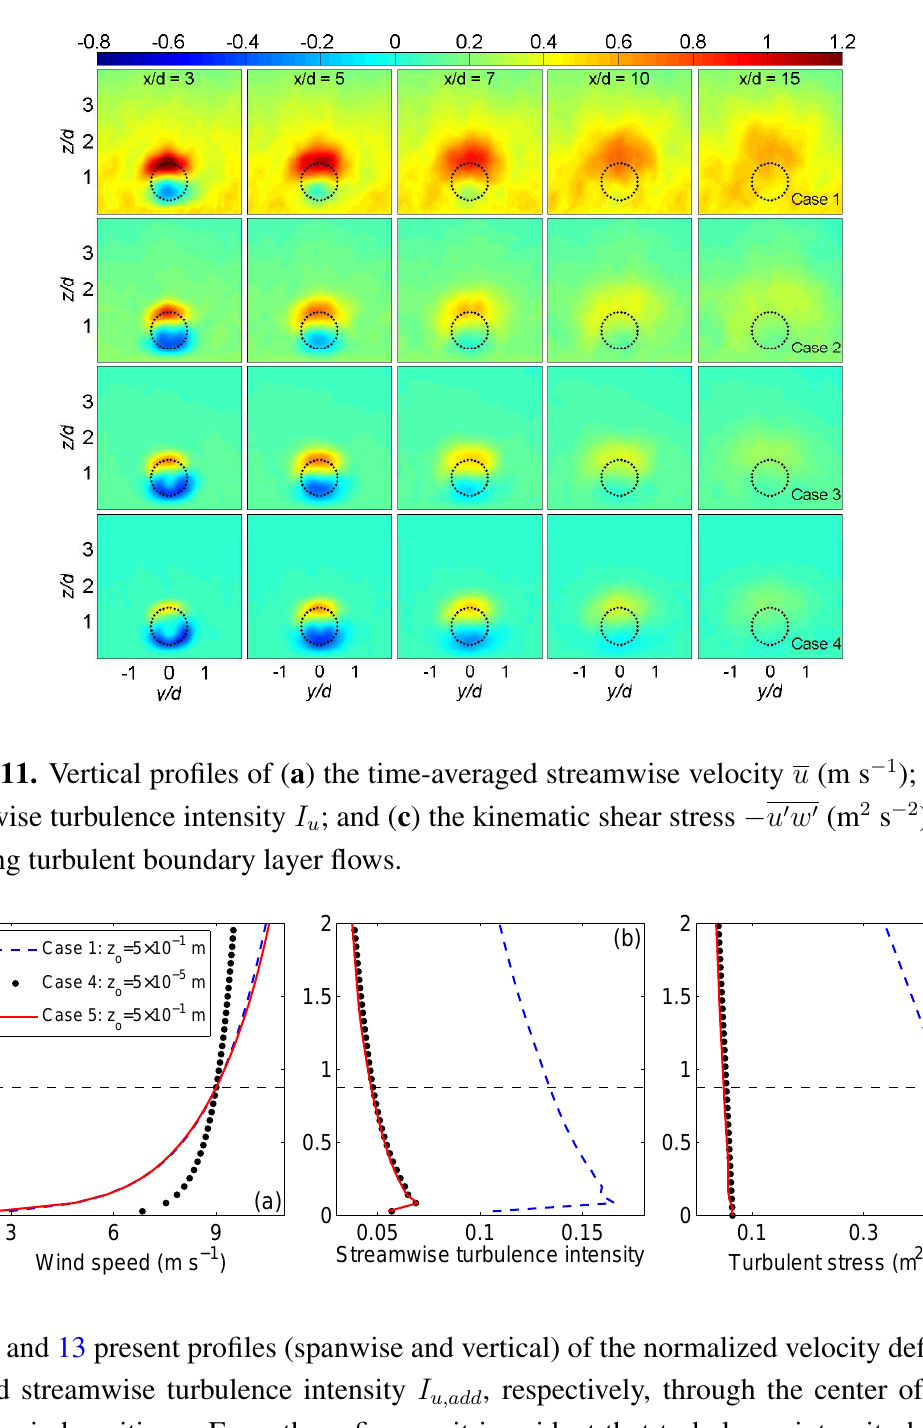
Figure 10. Contours of the kinematic shear stress τ planes of x/d = 3, 5, 7, 10, and 15 for the turbines installed over flat surfaces with four different roughness lengths. The dotted line denotes the rotor region.